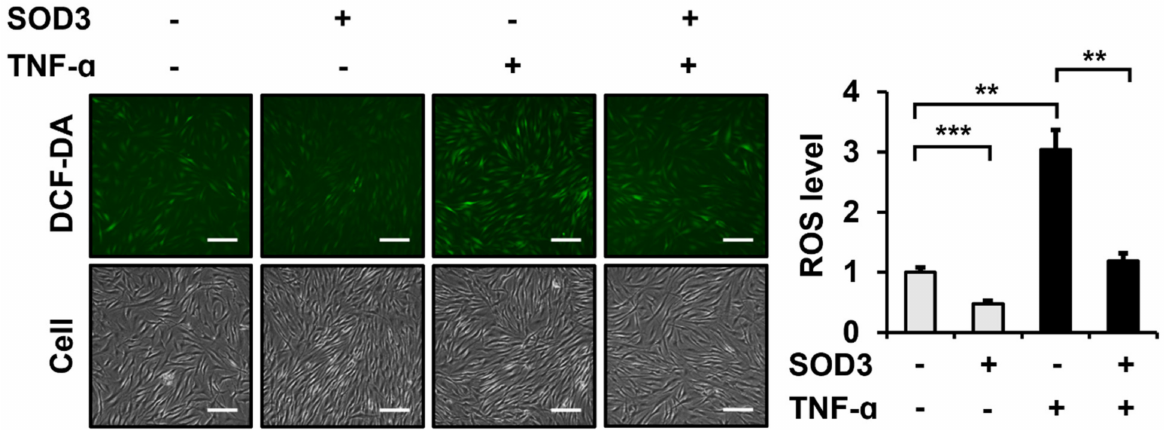
Figure 2. Effect of recombinant SOD3 treatment on the intracellular ROS levels in fibroblasts. Human foreskin fibroblasts were incubated in a serum-free medium in the presence of TNF- α (1 ng/mL) and/or SOD3 (3 µ g/mL) for 24 h. Intracellular ROS levels were measured by incubating the serum- free medium with 10 µ M DCF-DA for 30 min and detected as green fluorescence at 525 nm. ROS levels were normalized using crystal violet-stained cell counts. The graph shows ROS levels relative to the levels in untreated cells, which was assessed using the ImageJ software. Each value represents the mean ± standard deviation of three independent experiments. ** p < 0.01 and *** p < 0.001 vs. control. Magnification, × 200. Bar = 100 µ